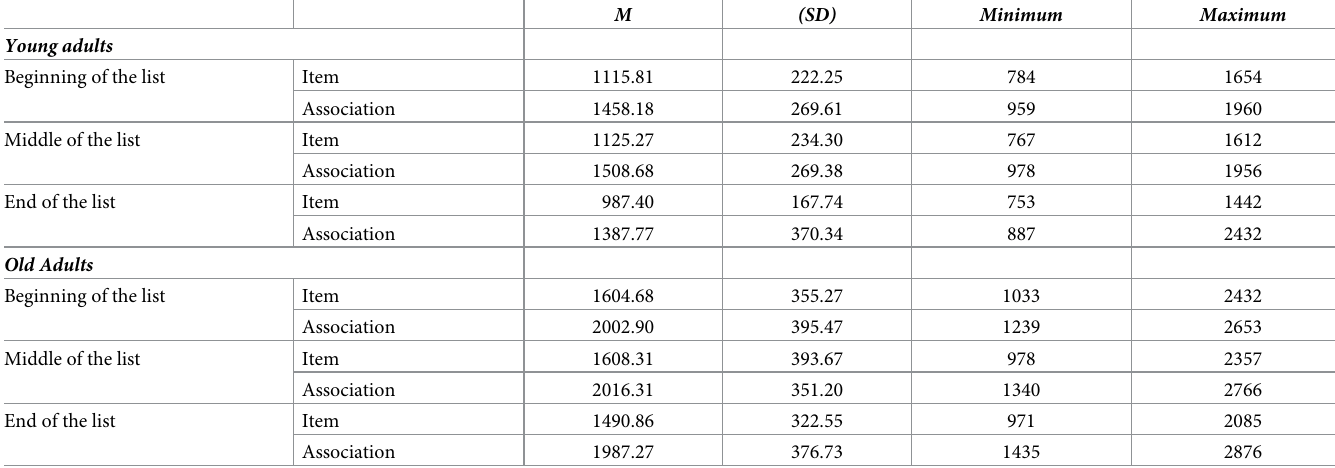
Table 2. Reaction-time (RT) means and standard deviations for item and associative recognition as a function of age and